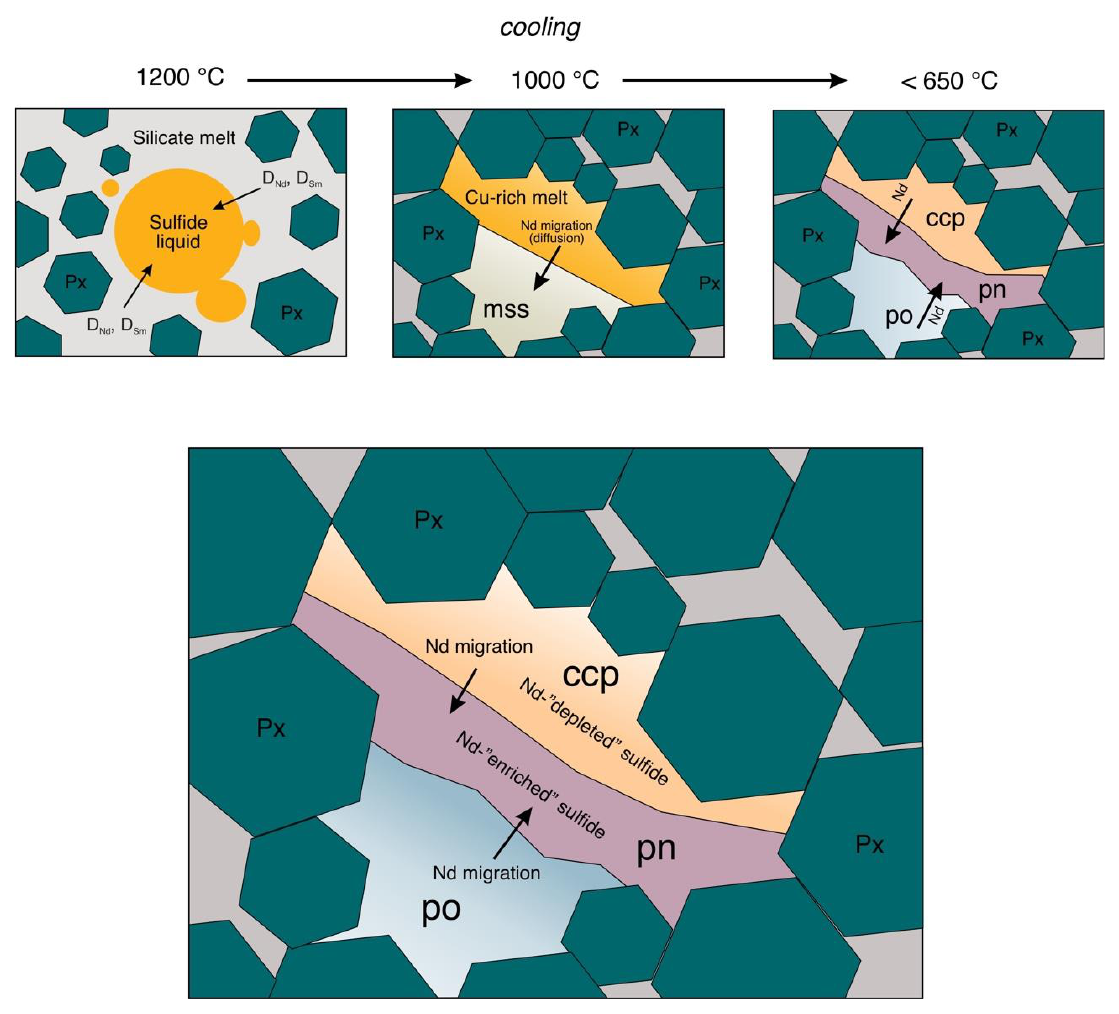
Figure 6. Chart of neodymium migration (diffusion) in magmatic sulfides in the course of sulfide- silicate liquid cooling. Px — pyroxene; ccp — chalcopyrite; pn — pentlandite; po — pyrrhotine.